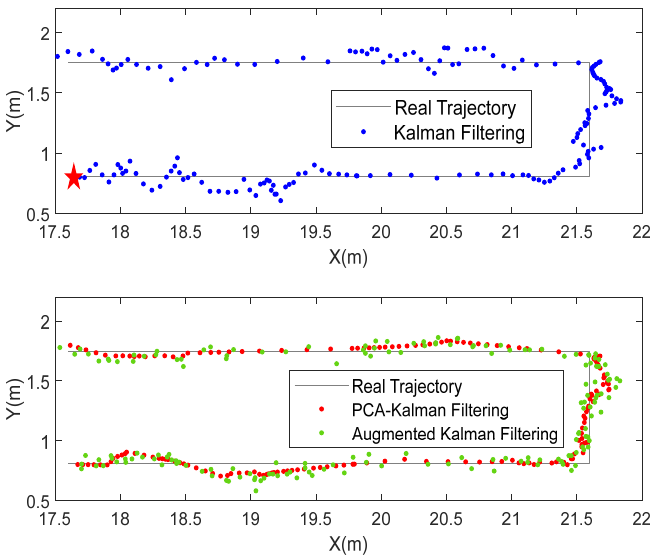
Figure 17. Positioning results. The experimenter starts from the red star.